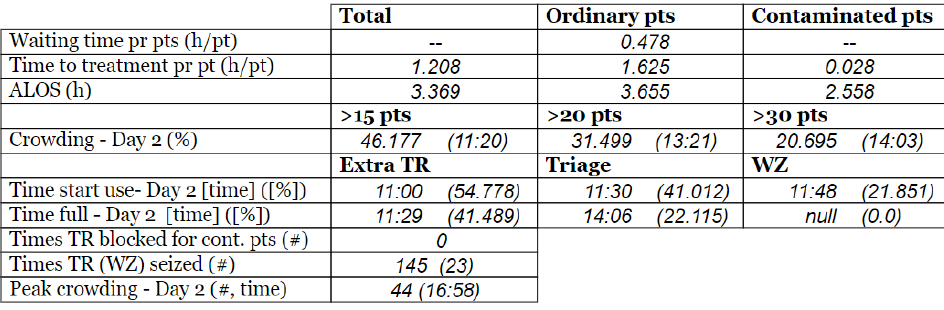
Figure 17. Snapshot of simulated KPIs of patient flow in a peri-pandemic setting.